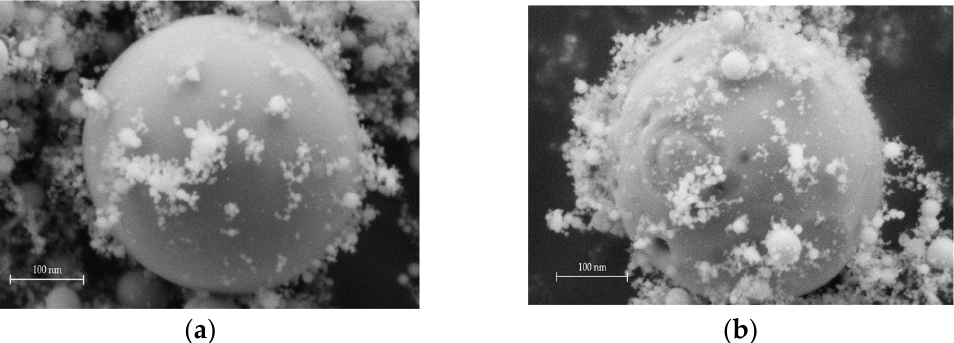
Figure 6. Microphotographs of aluminum oxide particles: ( a ) the original particles; ( b ) coated par- ticles.